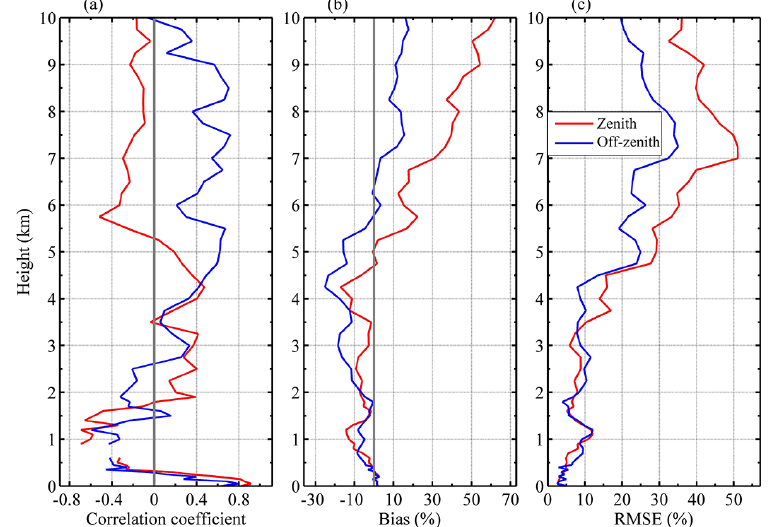
Figure 3. Same as Fig. 2 but for relative humidity profiles. Some breakpoints are shown in Fig. 3a because the compared RAOB relative humidity remains constant at these heights.